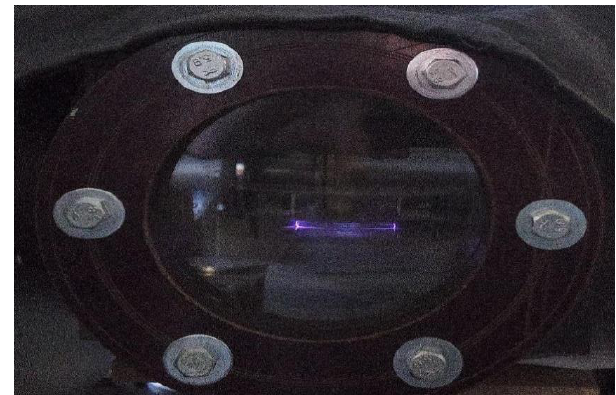
Figure 3. The image of the discharge glow above the surface of distilled water at an air pressure of 101 kPa.